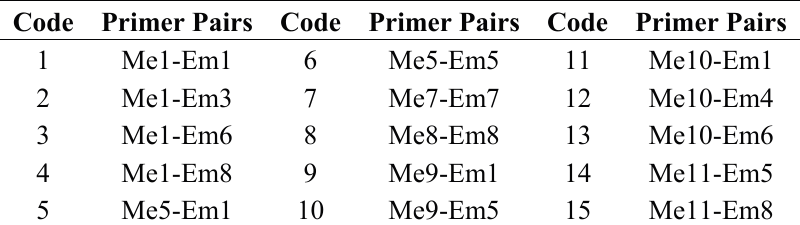
Table 4. The 15 SRAP primer pairs used in this